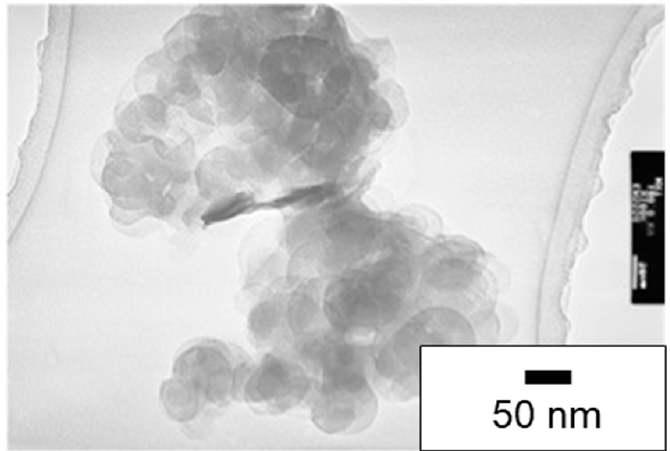
Figure 2. TEM image of nanometer size hydrotalcite prepared using ion exchange resin. Reproduced with permission from reference [81].